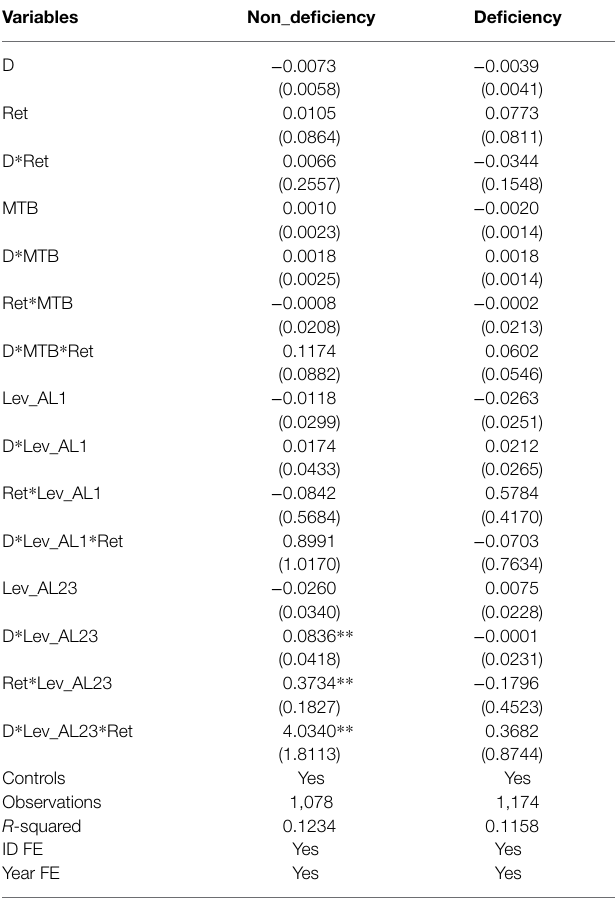
TABLE 7 | Grouping results of internal control